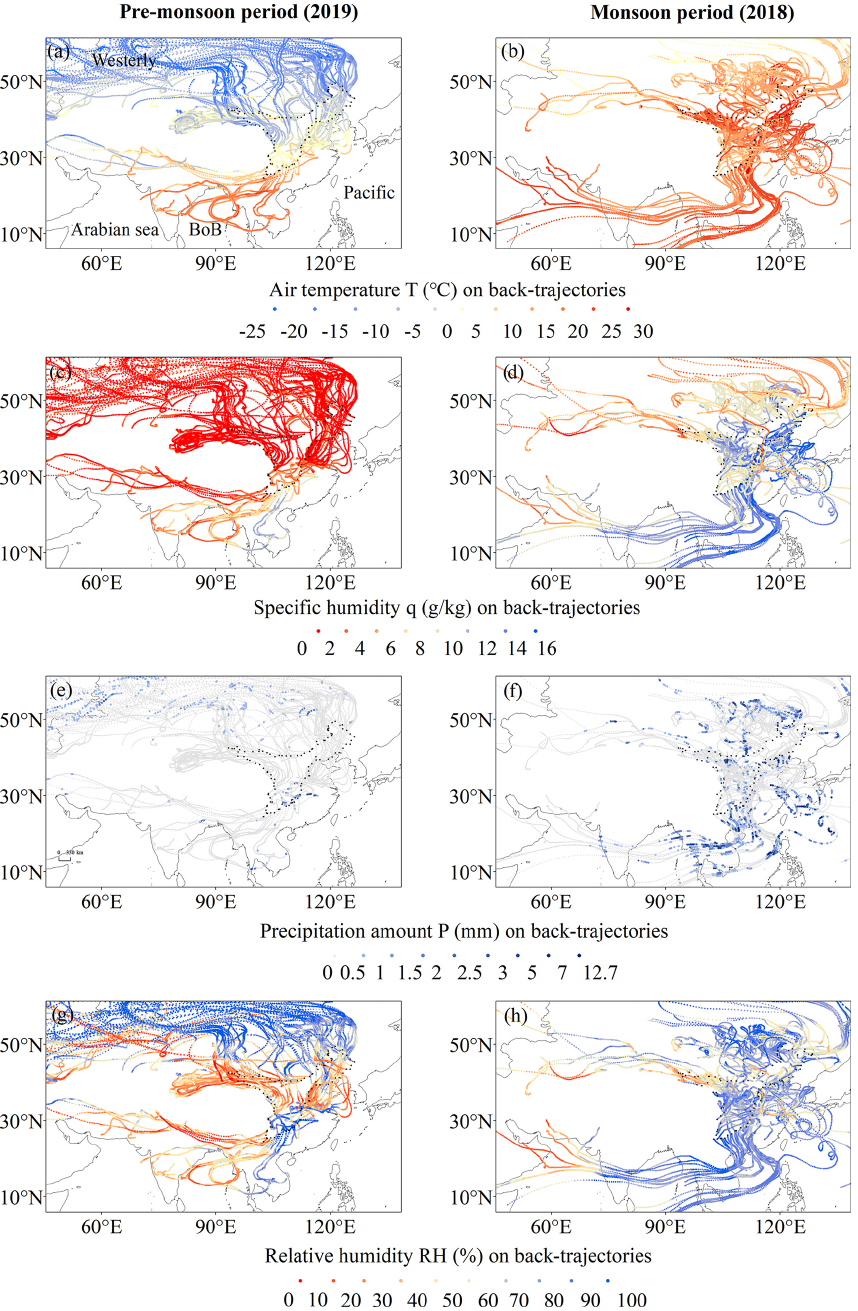
Figure 2. Meteorological conditions simulated by the HYSPLIT4 model along the 10d air back trajectories for the on-route sampling positions during the two surveys: (a, b) air temperature T ( ◦ C), (c, d) specific humidity q (gkg − 1 ), (e, f) precipitation amount P (mm), and (g, h) relative humidity RH (%). The left panel is for the pre-monsoon period, and the right is for the monsoon period. The driving locations and time every 2h are used as starting points. Note: BoB is the abbreviation for the Bay of